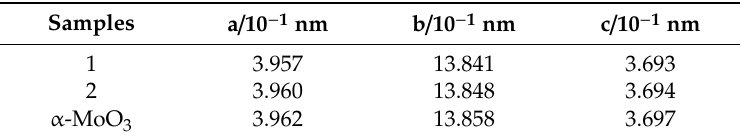
Figure 4. X-ray di ff raction (XRD) peaks of the recycled products and the standard pattern peaks Figure 4. X-ray diffraction (XRD) peaks of the recycled products and the standard pattern peaks of of MoO 3. MoO 3. Table 4. Crystal lattice constants of the recycled and α -MoO Table 4. Crystal lattice constants of the recycled and α -MoO 3.